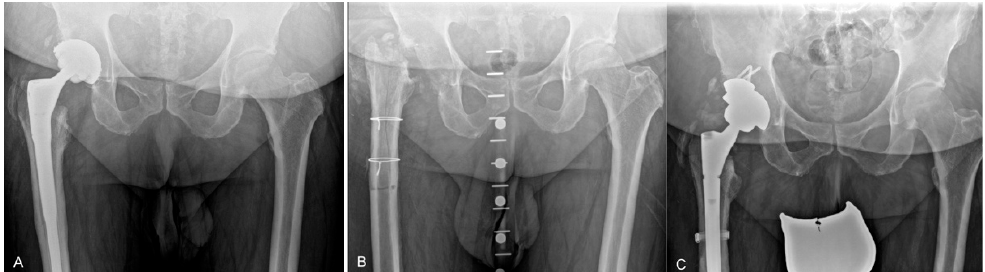
Figure 1. ( A ) Anteroposterior radiograph of a 68-year-old male patient with culture negative periprosthetic infection of the right hip showing a well-fixed cementless long stem 6 years after implantation. ( B ) Radiograph taken after first-stage total hip arthroplasty (THA) removal using an extended trochanteric osteotomy (ETO) with cerclage fixation without spacer insertion. ( C ) Postoperative radiograph showing the reimplantation after 7 weeks utilizing a highly porous metal shell with augment and modular fluted tapered stem. At the time of reimplantation, ETO was successfully healed and cerclages were exchanged.